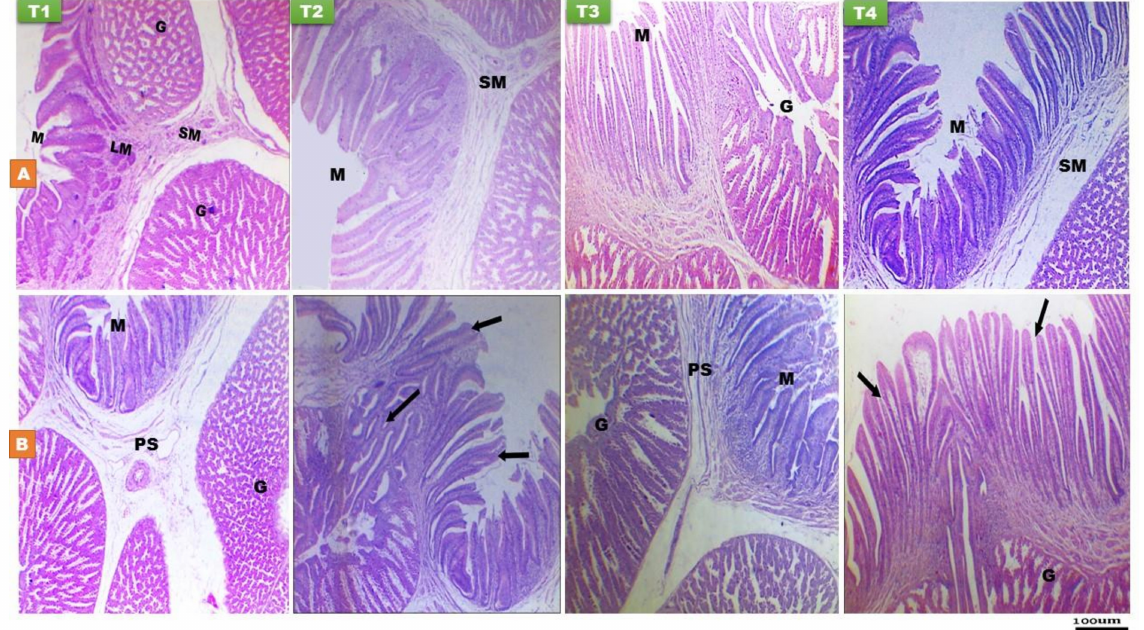
Figure 5. Histological structure of proventriculus at day 14 ( A ) and day 28 ( B ) of age of layer-type chicks exposed to fasting (control, T1) or early feeding on a layer starter diet (T2), a layer starter diet contained 3% molasses (T3), and a broiler starter diet (T4) during the first 72 h post-hatching. M, mucosa with longitudinal mucosal folds (black arrow); LM, lamina muscularis mucosae; PS, propria submucosa; SM, sub mucosa; G, submucosal gland. (H and E, ×